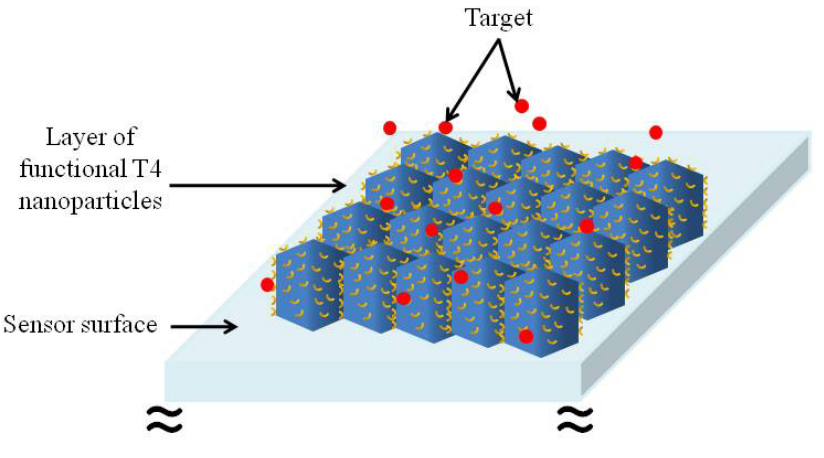
Figure 2. Schematic representation of a sensor surface which utilizes functional T4 nanoparticles as biorecognition elements. The detection of the target could be done through optical or electrical